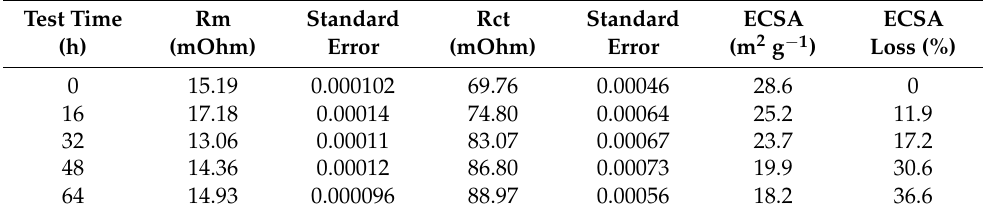
Table 1. Fitting results of EIS using equivalent circuit and the ECSA results.